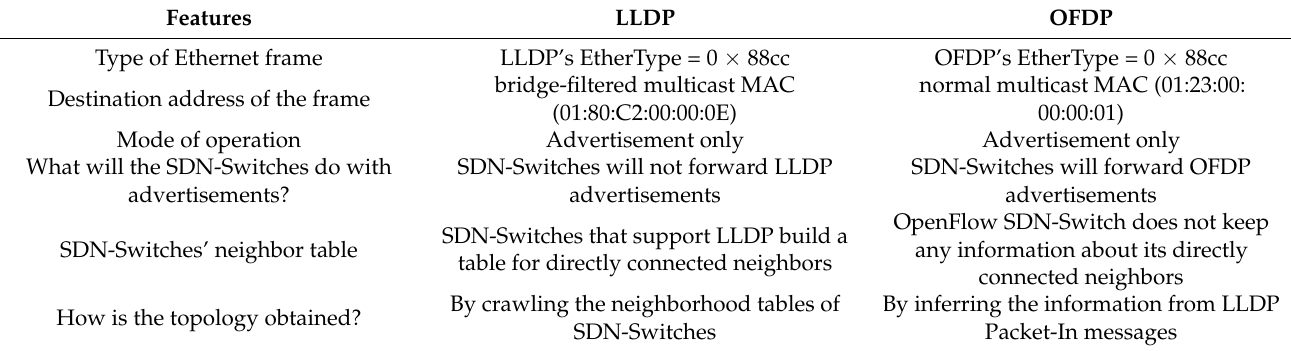
Table 1. Similarities and differences between LLDP and OFDP protocols